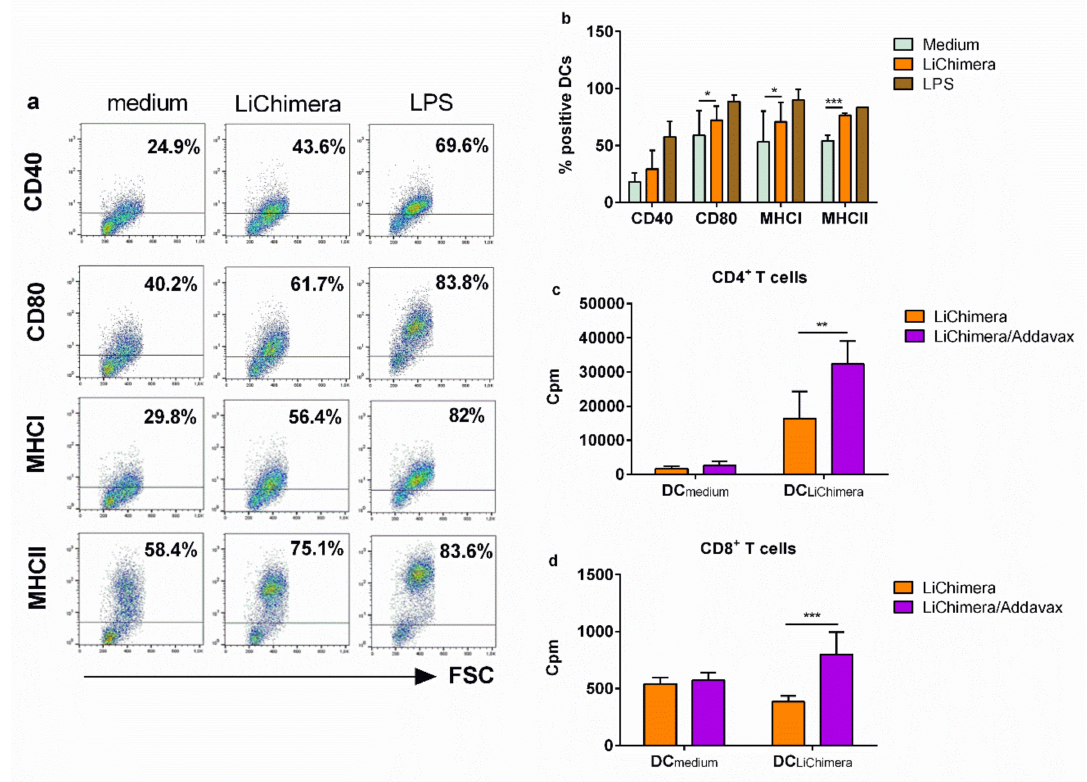
Figure 6. In vitro proliferation of CD4 + and CD8 + T cells in response to LiChimera-pulsed bone marrow-derived dendritic cells (BMDCs). BMDCs were pulsed with LiChimera for 24 h and expression of CD40, CD80, MHCI, and MHCII was detected with flow cytometry. The BMDCs pulsed with medium alone or lipopolysaccharide (LPS) served as control groups. ( a ) Representative flow cytometry dot plots are shown from three independent experiments; ( b ) Percentage of BMDCs expressing CD40, CD80, MHCI, and MHCII molecules; ( c , d ) BMDCs were stimulated with LiChimera for 18 h. BMDCs stimulated with medium alone served as the control. After 18 h, 2 × 10 4 BMDCs were cocultured with 1 × 10 5 CD4 + T (c) or CD8 + T ( d ) cells isolated from mouse vaccinated with LiChimera or LiChimera / Addavax, for 72 h. T cell proliferation was determined by [ 3 H]-thymidine incorporation after another 18 h of culture and expressed as counts per minute (cpm). Data are expressed as triplicate means ± s.d. Significant di ff erences between groups are indicated with asterisks measured by one-way ANOVA and Tukey’s multiple comparison tests. * p < 0.05, ** p < 0.01, and *** p <